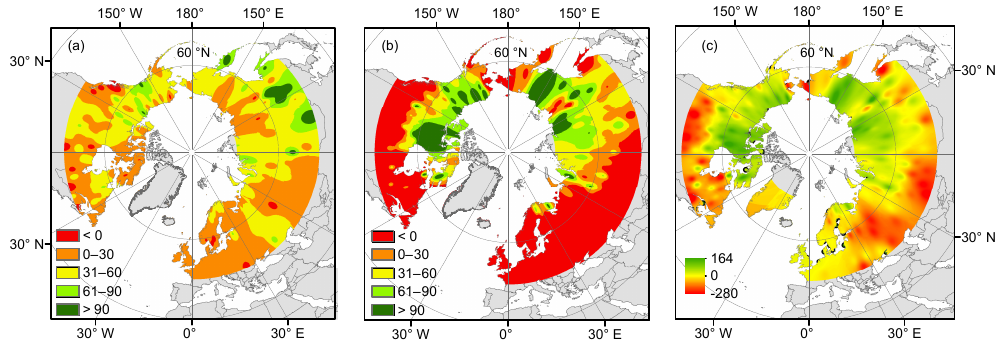
Figure 6. Modelled mean C accumulation rate (g Cm − 2 yr − 1 ) interpolated among simulation points for (a) 1990–2000 and (b) 2090–2100; (c) net change in total accumulation rate (b–a)